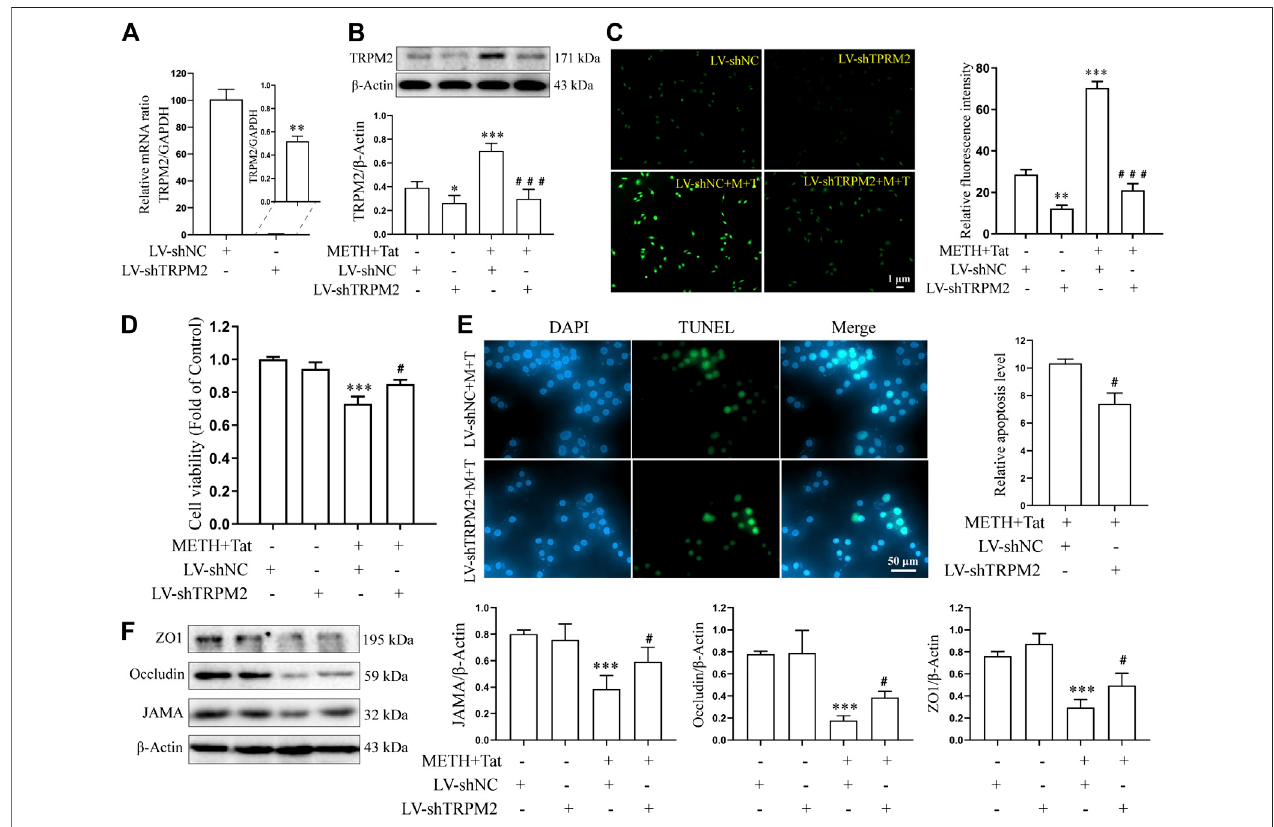
FIGURE6| TRPM2geneknockdown attenuatesdamagetotheBBBsynergisticallyinducedbyMETHand HIV-Tat invitro .ThehCMEC/D3 cellsweretransfected with LV-shTRPM2 or LV-shNC for 48 h before 0.5 mM of METH and 100 nM of HIV-Tat for 24 h. (A) Real-time qPCR was performed to determine the TRPM2